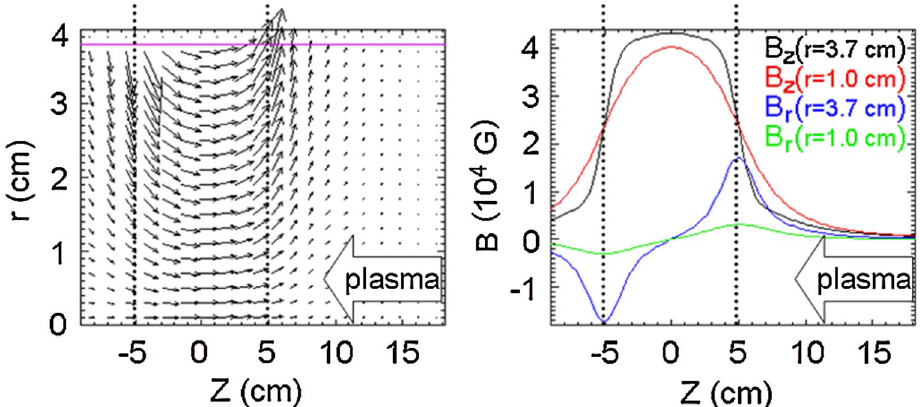
(cid:9) z (cid:10) and B (cid:9) z (cid:10) magnetic field components at r (cid:6) 1 and r z (cid:2) 10 12 cm (cid:1) 3 with v i (cid:6) (cid:1) 1 : 44 cm =(cid:1) s is injected in the upstream ( (cid:1) ^ z ) direction, towards the B p z